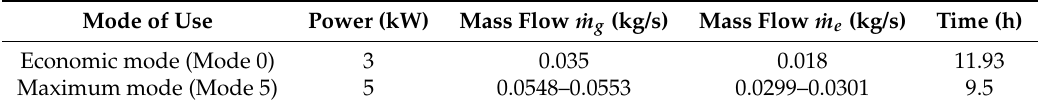
Table 6. Comparison of the economic mode and the maximum mode for a radiation of 500 kW/m 2 .